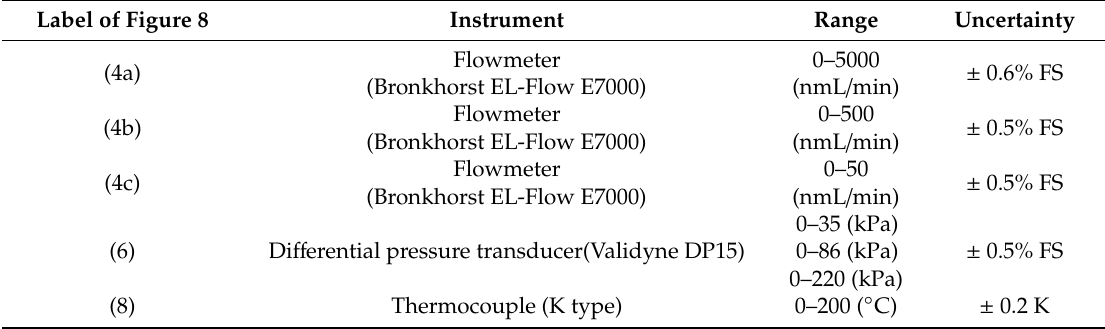
Table 1. Characteristics and uncertainties of the measurement